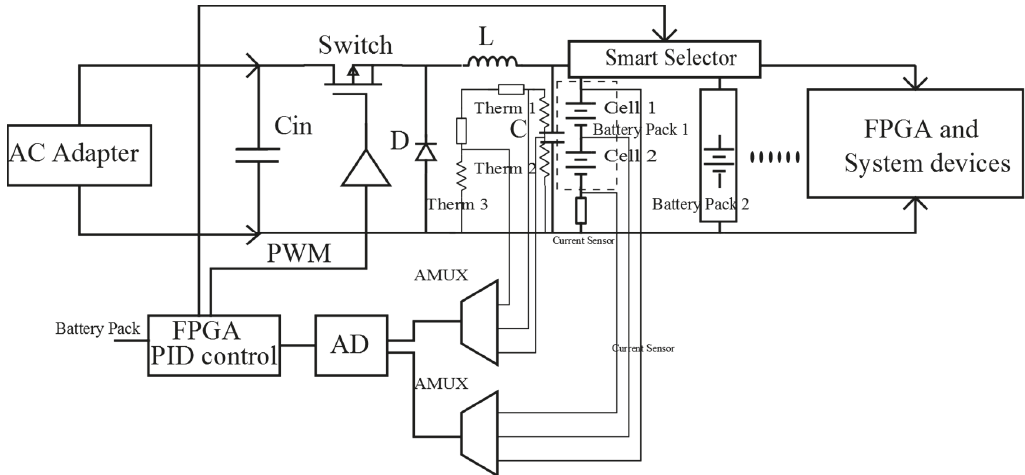
Figure 2. Smart charging block diagram based on PI control.